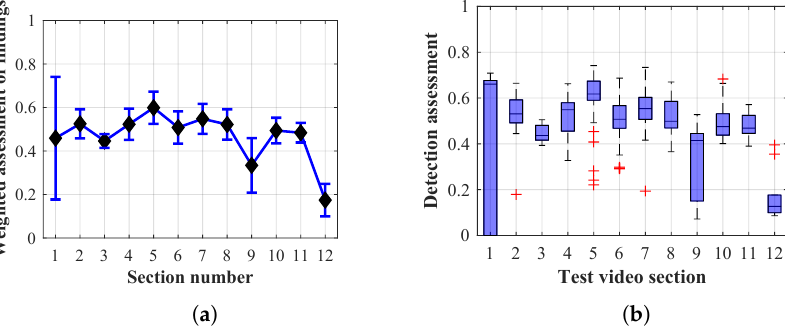
Figure 40. Results of Method 2.2 with a lifespan of 12 frames. ( a ) the weighted average rating with the average mean absolute error of the weighted rating and ( b ) boxplots of the distribution of the statistical sets of the results of the individual sections evaluated indicating: minimum, 1st quartile, median, 3rd quartile, maximum.